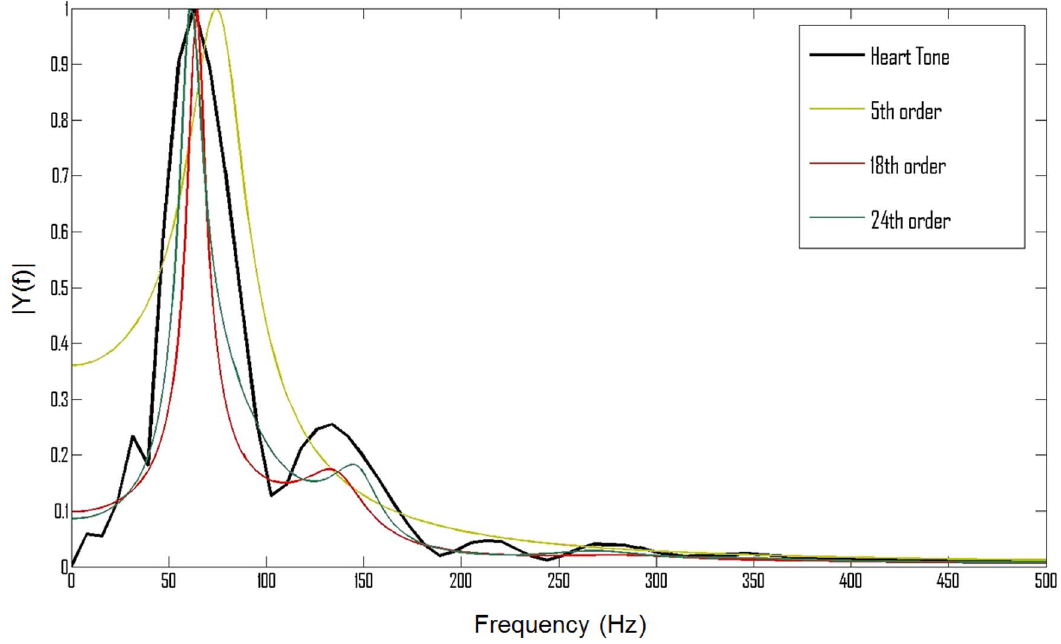
Figure 3. A S3 heart tone and LPC filter spectra. A comparison between a real S3 heart tone spectrum and spectra of filters estimated by the LPC algorithm. The 24th order filter provides the closest representation of the original heart tone spectrum.